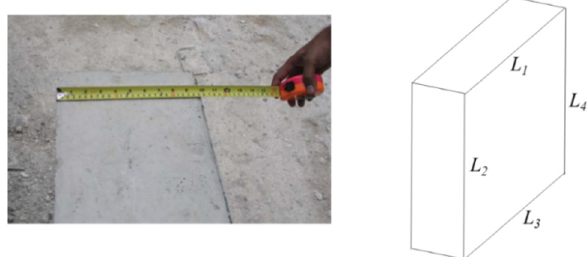
Figure 3. Measurement of dimensions (e.g., L 1 to L 4 ) of a structural